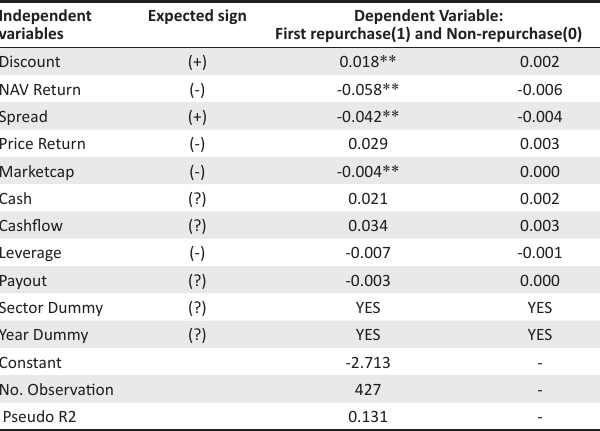
TABLE A1: Multivariate analysis for the first repurchase decision. This table presents logit results for the 427 fund-date observations. In this sample, there are 76 first repurchasers and randomly selected 351 non- repurchasers from 23 September 1998 to 16 December 2009. Discount, NAVreturn, Spread, Pricereturn and Marketcap are market variables using data on the trading day prior to the first repurchase and non-repurchase dates. Cash, Cashflow, Leverage and Payout are accounting variables using data at the fiscal year-end prior to the first repurchase and non-repurchase dates. All variables are defined in Table 3 Panel B. Here I only report coefficients and marginal effects for the model with the best fitness or highest Pseudo R2. * , ** and *** denote statistical significance at the 10 % , 5 % and 1 % level respectively. Expected signs are derived from